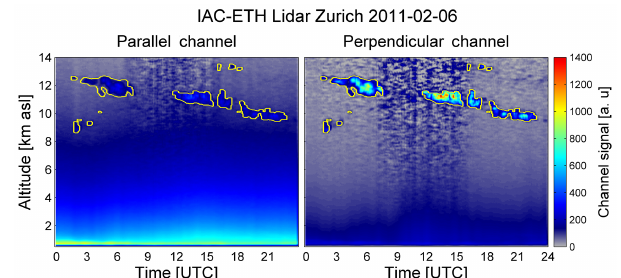
Figure 1. Cloud detection applied to a lidar measurement from Zürich: co-polarized (left) and cross-polarized (right)